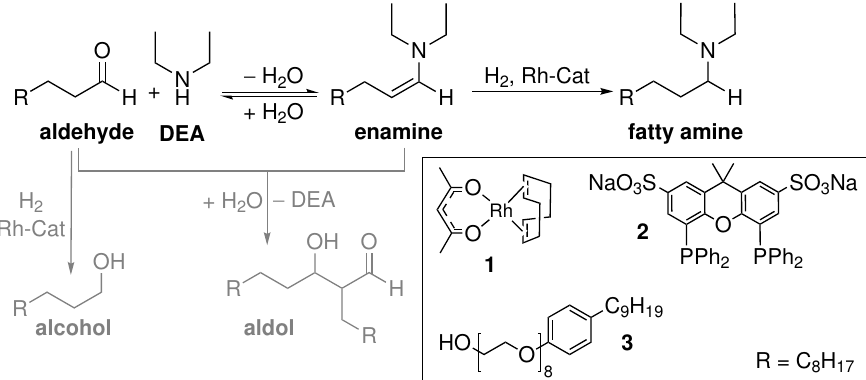
Figure 1. Reaction scheme of the Rh-catalyzed reductive amination of undecanal with diethylamine to give the fatty amine N,N-diethylundecylamine; the grey highlighted side reactions of undecanal: the Rh-catalyzed alcohol reduction and the enamine-catalyzed self condensation of undecanal; the used Rh-precursor 1 , the bidentate phospine ligand SX 2 and the used non-ionic surfactant Marlophen NP8 3